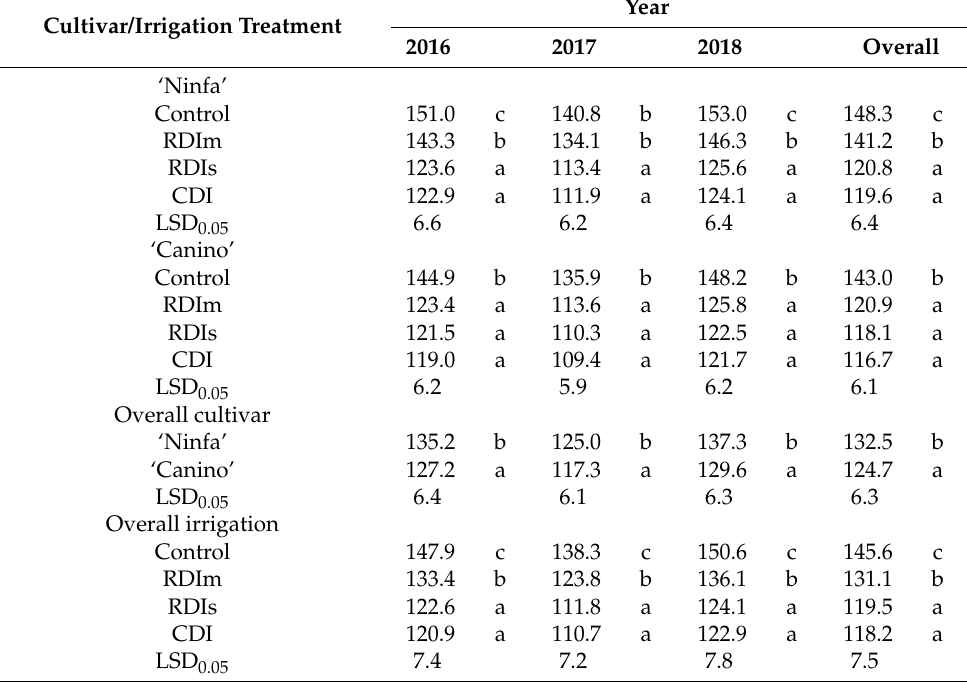
Table 8. The effects of three years (2016, 2017, 2018), deficit irrigation treatments (control, moderate regular deficit irrigation—RDIm, severe regular deficit irrigation—RDIs and continuous deficit irrigation—CDI) and two cultivars (‘Ninfa’ and ‘Canino’) on the soluble carbohydrates content (TSC, mg g − 1 ) in a commercial apricot orchard at Wadi El Natrun, Northern Egypt. Explanation for irrigation treatments, calculations of significant differences, and explanations for LSD 0.05 values are given in Figure 3; ns: nonsignificant. Different letters represent significant differences among DI